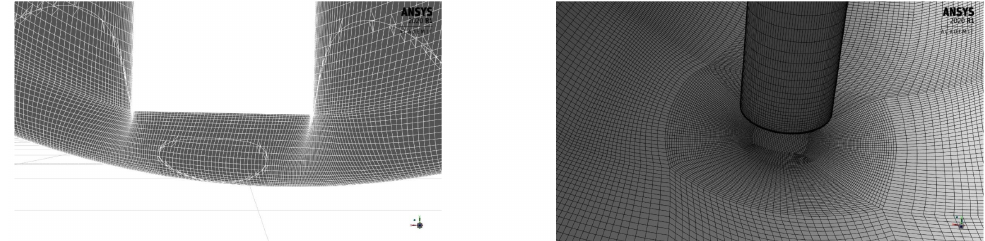
Figure 20. Mesh morphed with corrective solutions. ( Left ): deformed mesh around the tip. ( Right ): deformed surface mesh